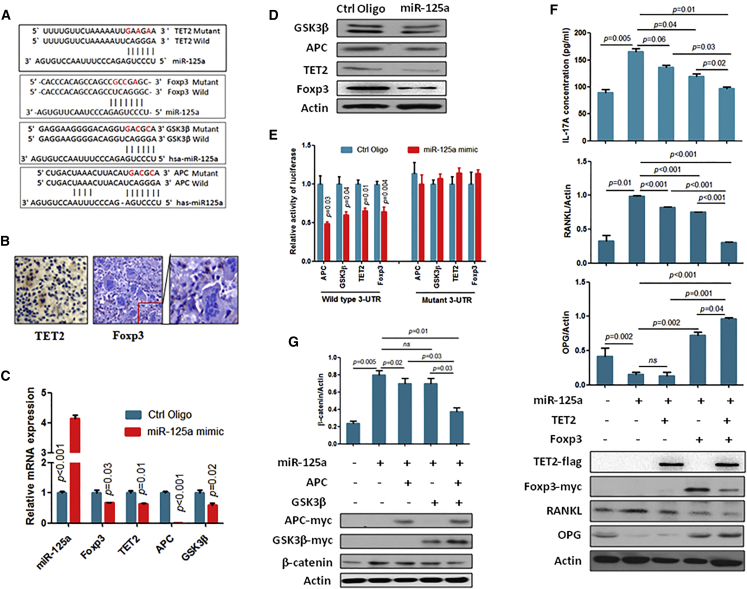
miR-125a Directly Targets Multiple Negative Regulators of IL-17A and β-Catenin(A) Predicted binding sites of miR-125a in the wild-type 3′ UTRs of Foxp3, TET2, GSK3β, and APC. Mutations in these 3′ UTRs are highlighted in red. (B) TET2 and Foxp3 expression was detected in GCTB specimens by IHC. (C) After 72 hr of transfection with miR125a mimics, the stromal cells were subjected to qRT-PCR analysis for detecting the indicated gene’s mRNA level. (D) After 72 hr of transfection with miR125a mimics, the stromal cells were subjected to western blot analysis to detect the indicated protein’s level. (E) Luciferase activity of reporter with wild-type or mutant 3′ UTRs of Foxp3, TET2, APC, and GSK3β in the stromal cells cotransfected with the indicated oligonucleotides. (F) Stromal cells were infected with the indicated gene expression lentiviral vectors. After 72 hr of infection, cell culture medium and cells were subjected to measurement of IL-17A concentration and western blot analysis, respectively. (G) After 72 hr of infection with the indicated gene expression lentiviral vectors, the stromal cells were subjected to western blot analysis for detecting the indicated protein’s expression.